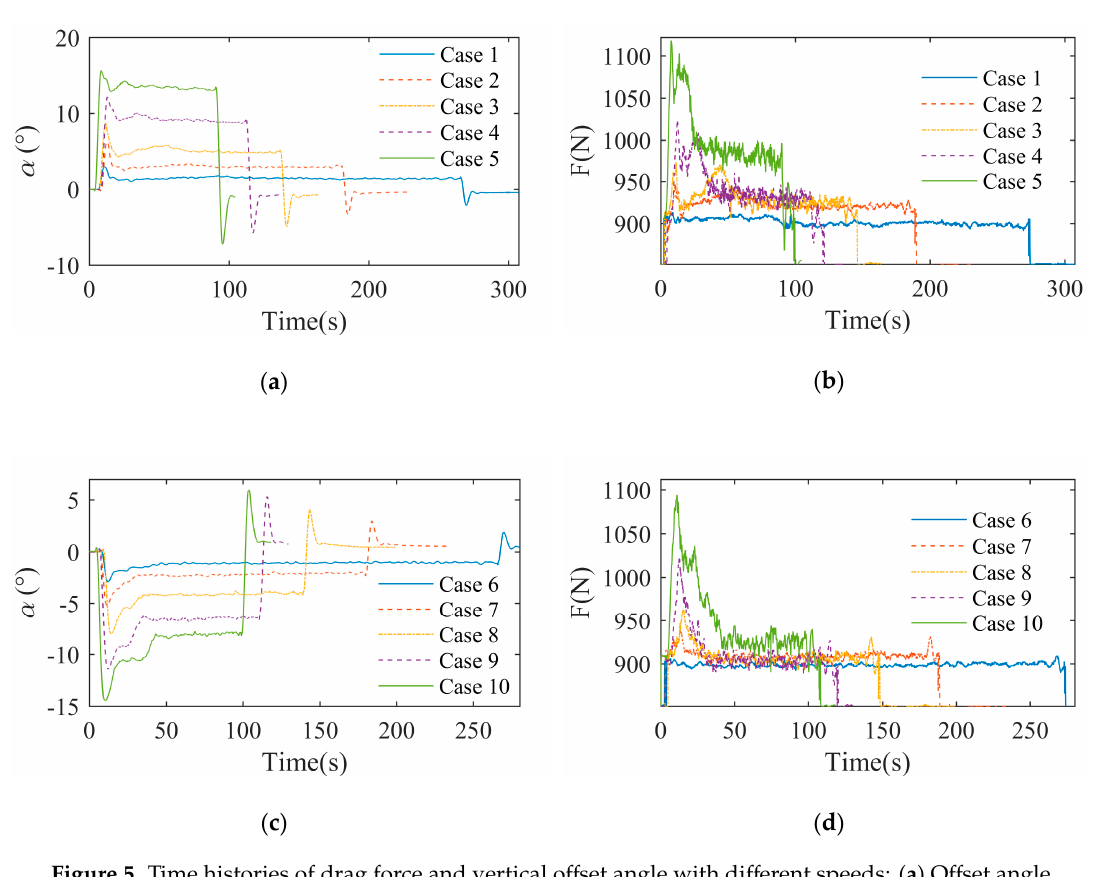
Figure 5. Time histories of drag force and vertical o ff set angle with di ff erent speeds: ( a ) O ff set angle variation for X-direction towing, ( b ) Drag force variation for X-direction towing, ( c ) O ff set angle variation for Y-direction towing, ( d ) Drag force variation for Y-direction